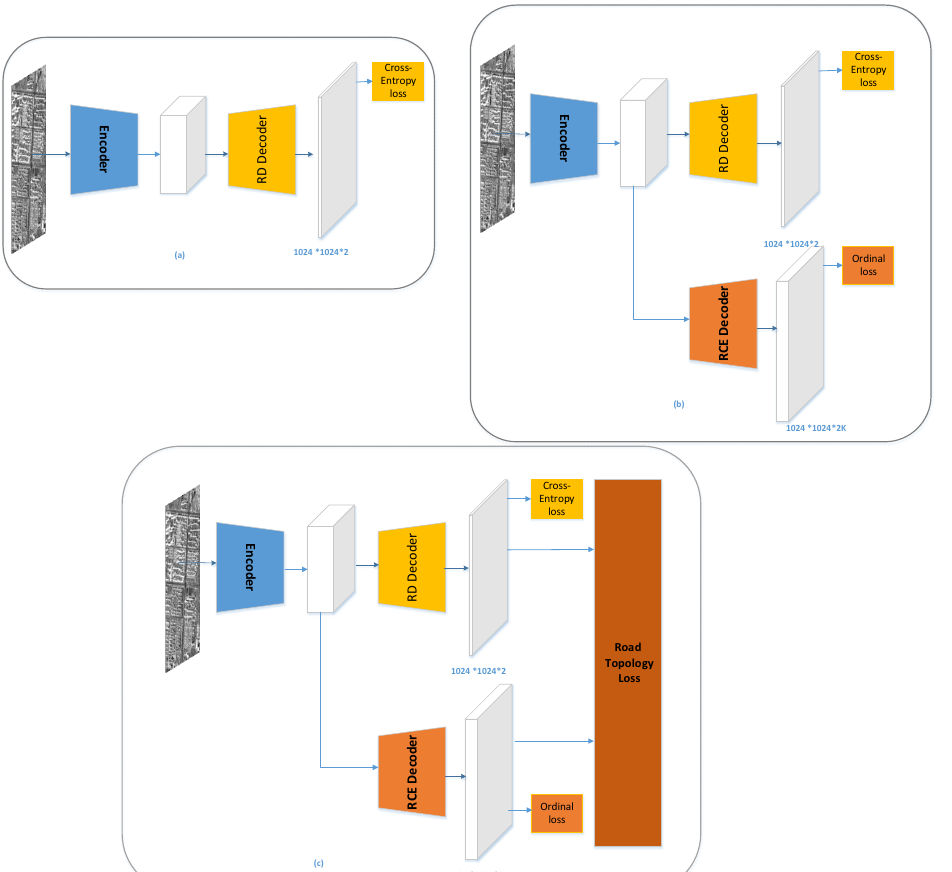
Figure 4. ( a ) baseline methods with only road detection branch; ( b ) the methods obtained by modifying baseline methods with road centerline extraction branch. ( c ) the methods obtained by modifying baseline methods with road centerline extraction branch androad-topology loss. ‘RD’ denotes the road detection; ‘RCE’ denotes the road centerline